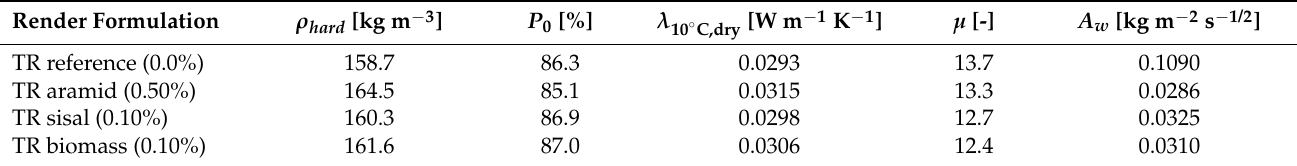
Table 2. Synthesis of some of the parameters previously characterised—average values adapted from